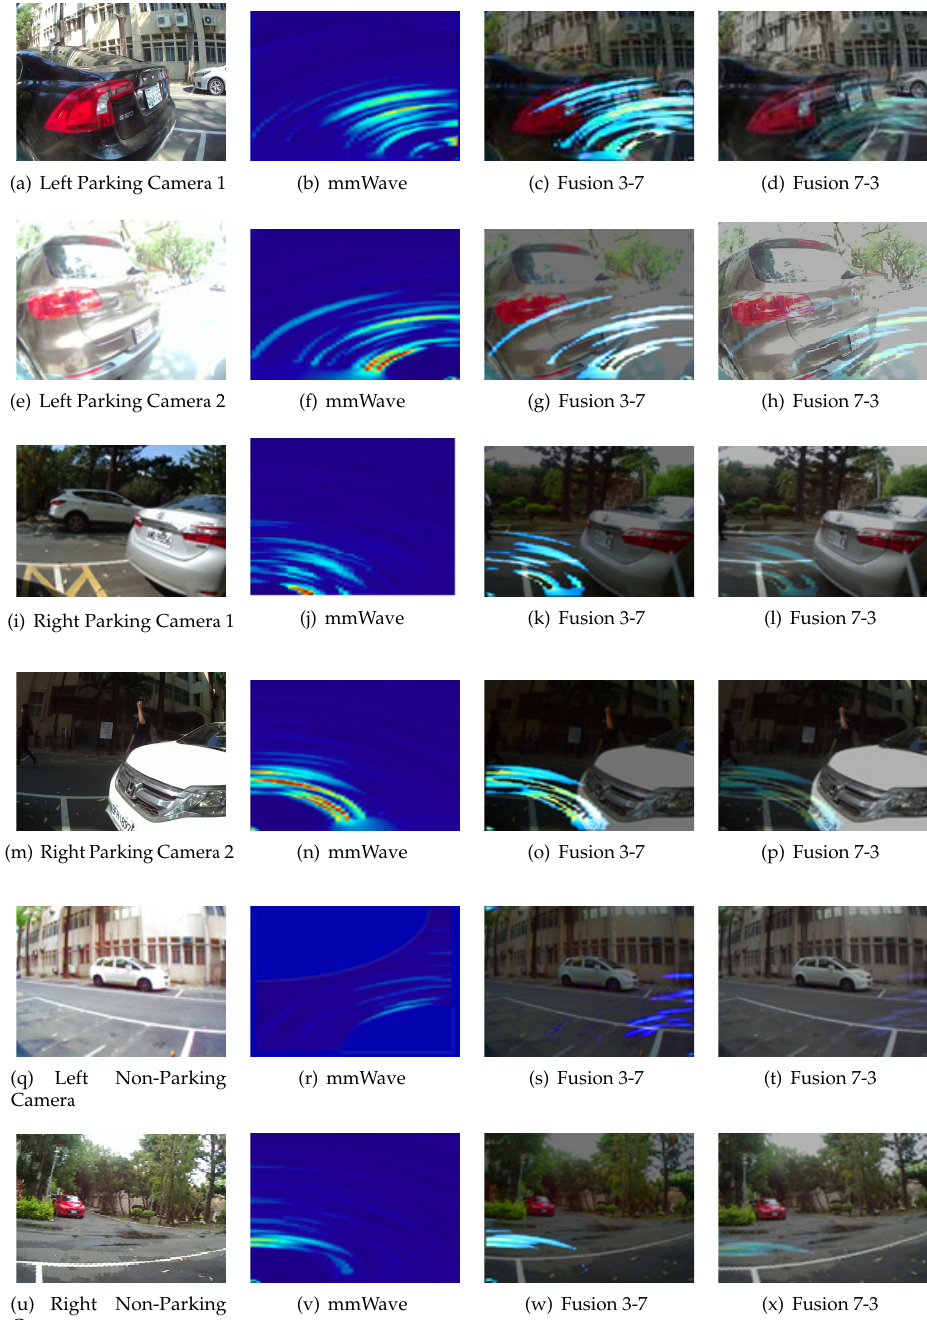
Figure 15. The results of the proposed algorithm to collected dataset on the street.